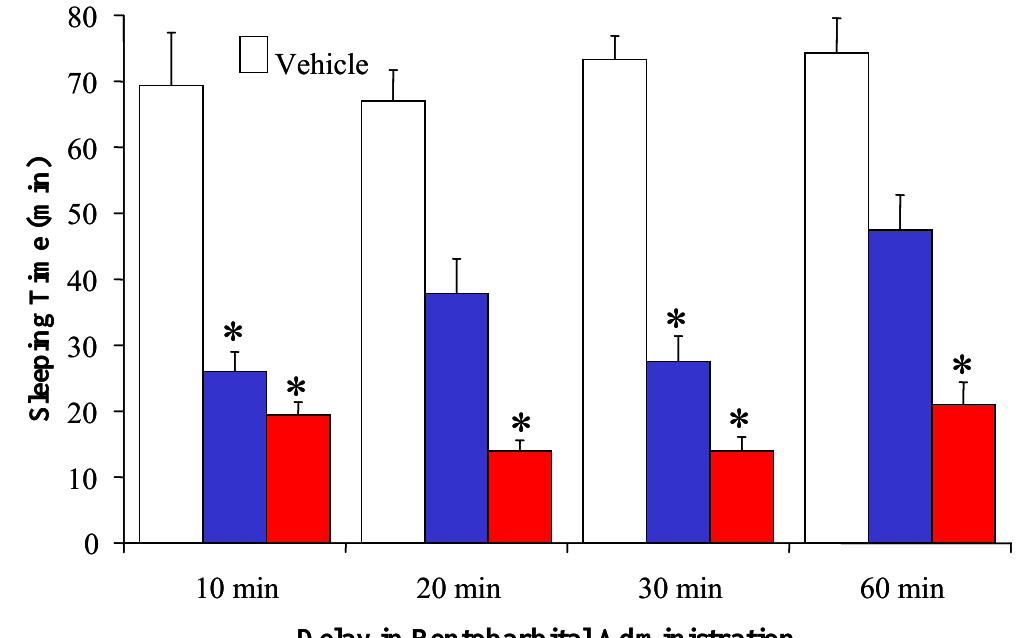
Figure 6. Comparison of the analeptic effect of equimolar doses (15 μ mol/kg body weight, i.v.) of TRH ( ) and its [pyridinium 2 ] analogue with n=1 ( ) administered in its prodrug form upon varying the time for pentobarbital treatment (60 mg/kg body weight, i.p.) post- drug administration. * indicates statistically significant differences (ANOVA followed by Dunnett’s test, P <0.05) from vehicle control. Reprinted with permission from [63]. © 2004 American Chemical Society.